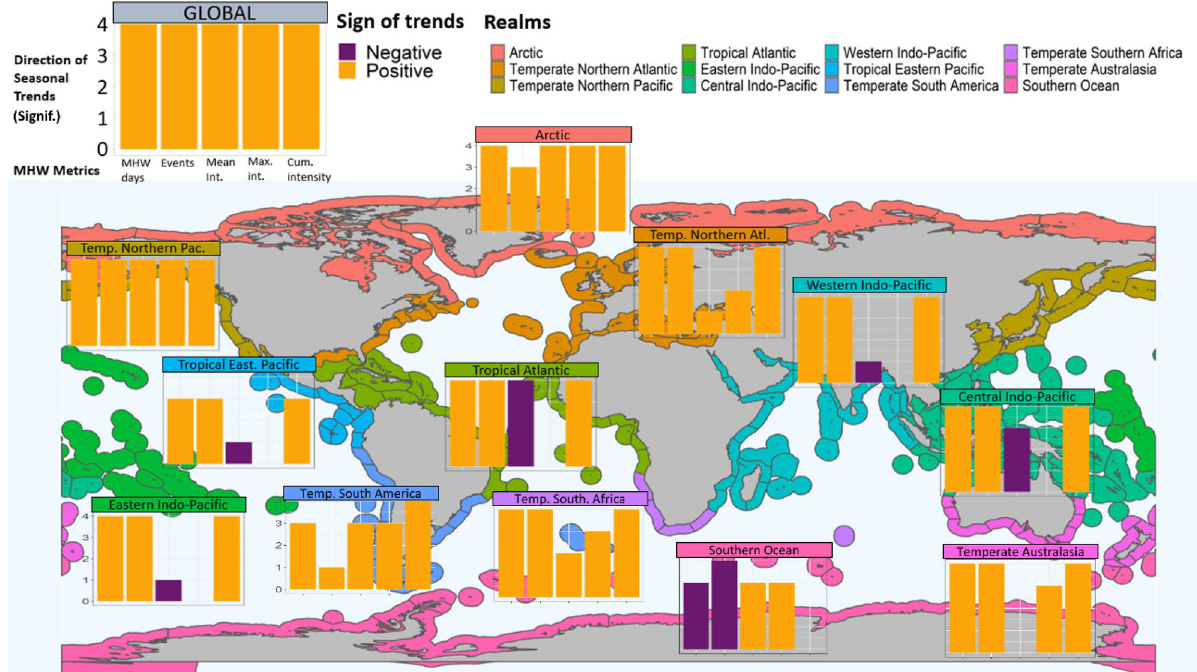
Figure 1. Map showing the direction of trend from seasonal analyses on MHW days, number of events, mean intensity, maximum intensity, and cumulative intensity (bars from left to right; 4 seasonal analyses per metric) at a global scale (insert, 260,010 pixels) and for 12 coastal realms (map) 22 . Of the 240 analyses (12 regions ×